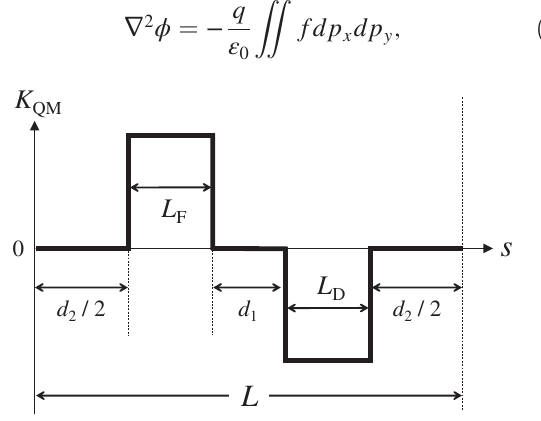
FIG. 1. Quadrupole doublet (FODO)